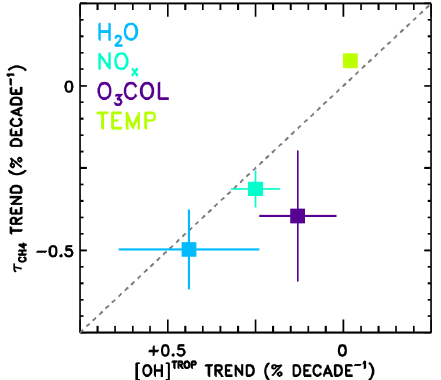
Figure 10. Comparison of the attributed trends in τ CH found in 4 this work according to the REF-C1SD simulations performed for CCMI ( y axis) to the attributed trends in tropospheric mean OH (“[OH] TROP ”) found based on observations in Nicely et al. (2018). The grey dashed line indicates the − 1 : 1 line, as values should be anti-correlated. The τ CH trend numbers from this work for NO x 4 combine the NO x total abundance and partitioning (NO / NO x ) val- ues from Fig. 9, and for the O 3 column combine the J( O 1 D ) and O 3 column values, as both effects are encompassed in the determi- nation of [OH] TROP